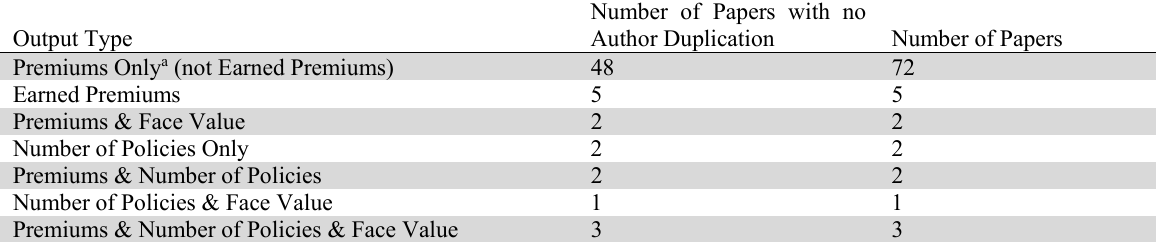
Counts of output proxies papers using premiums Output